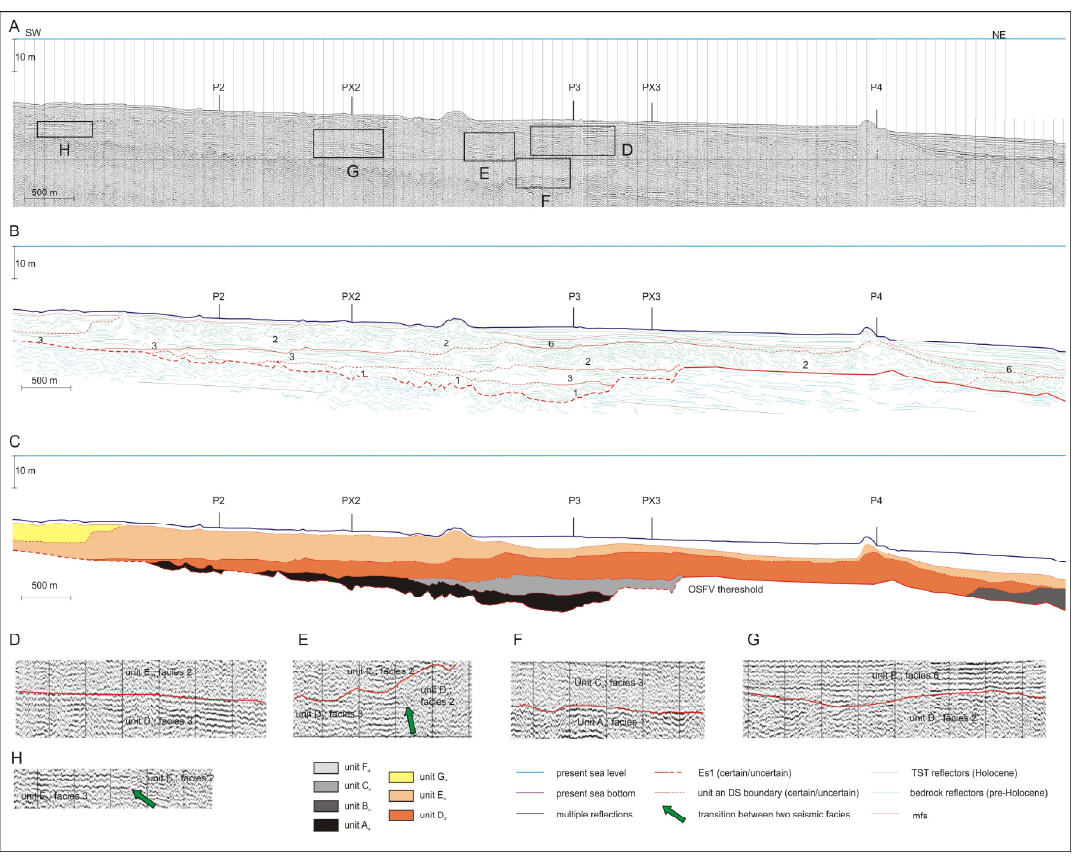
Figure 9. Part of seismic profile T5. Seismic section ( A ), interpretation ( B ), seismic unit recognised ( C ), enlargement of some significant sectors of the unconformities between units and some transitions between different seismic facies ( D–H ). In this profile, in particular, the two sets of opposite inclined reflectors that characterise the central body (seismic facies 2) of the unit D u , the position of the central body of unit E u (seismic facies 2) above the backbarrier deposits (seismic facies 3) of the former unit D u , and the landward backstepping pattern of unit D u and unit E u are evident. The legend reported below applies until Figure 13 and for Figure 15; the numbers reported in the interpretations of Figures 9–13 indicate the seismic facies.